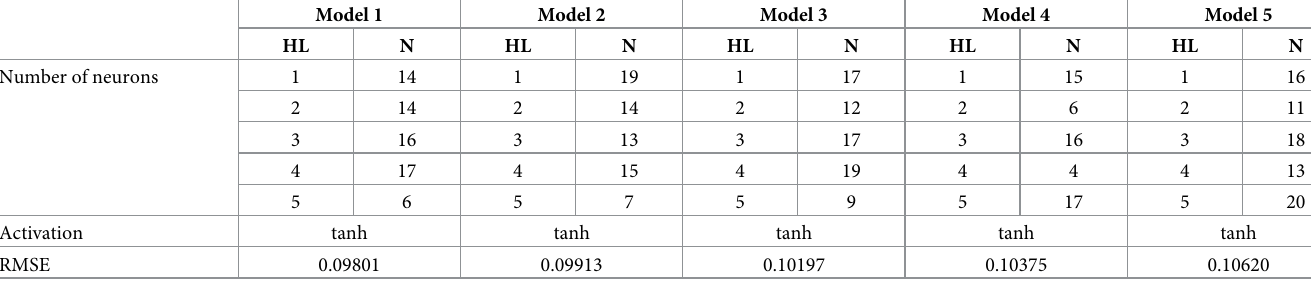
Table 12. Hyperparameter search results summary (Run 5). Top 5 Models out of 250 candidate models from Run